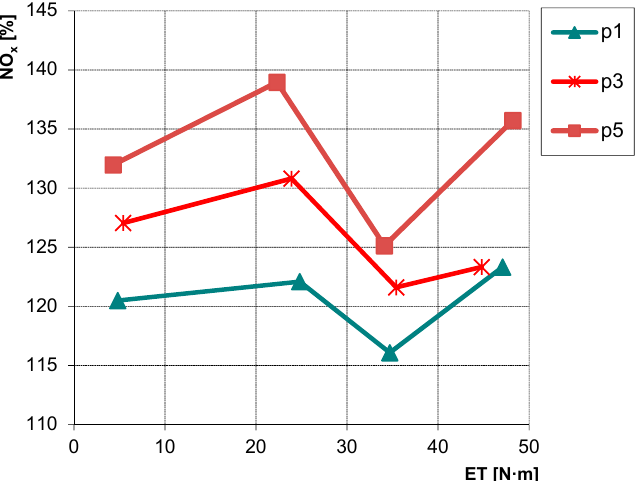
Figure 14. Changes in NO x (nitrogen oxides) emissions under load characteristics.